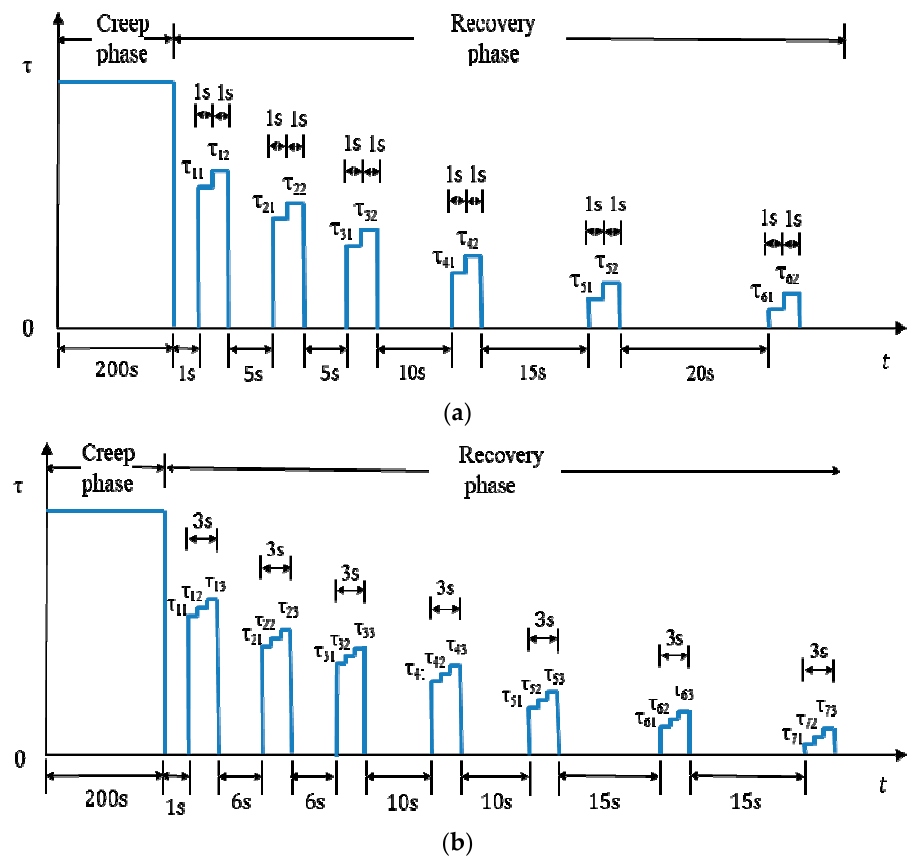
Figure 1. Loading conditions of the creep and step-loading recovery (CSR) test in asphalt binders. ( a ) Nondestructive CSR test; ( b ) Destructive CSR test.